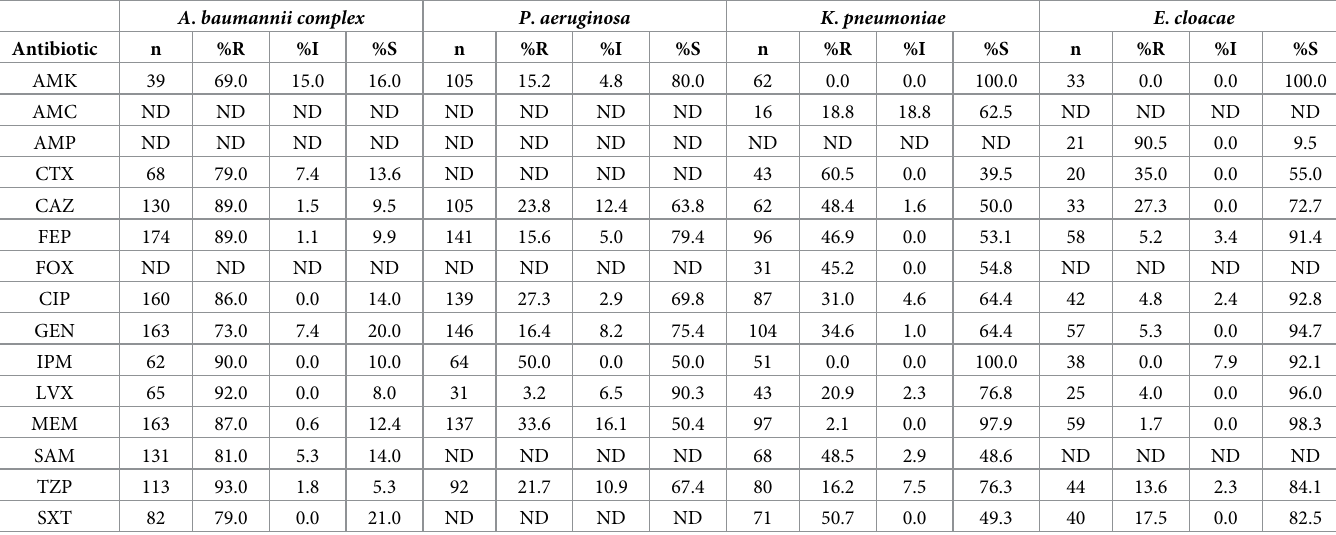
Table 4. Percentage of resistant, intermediate, and susceptible gram-negative isolates collected from respiratory